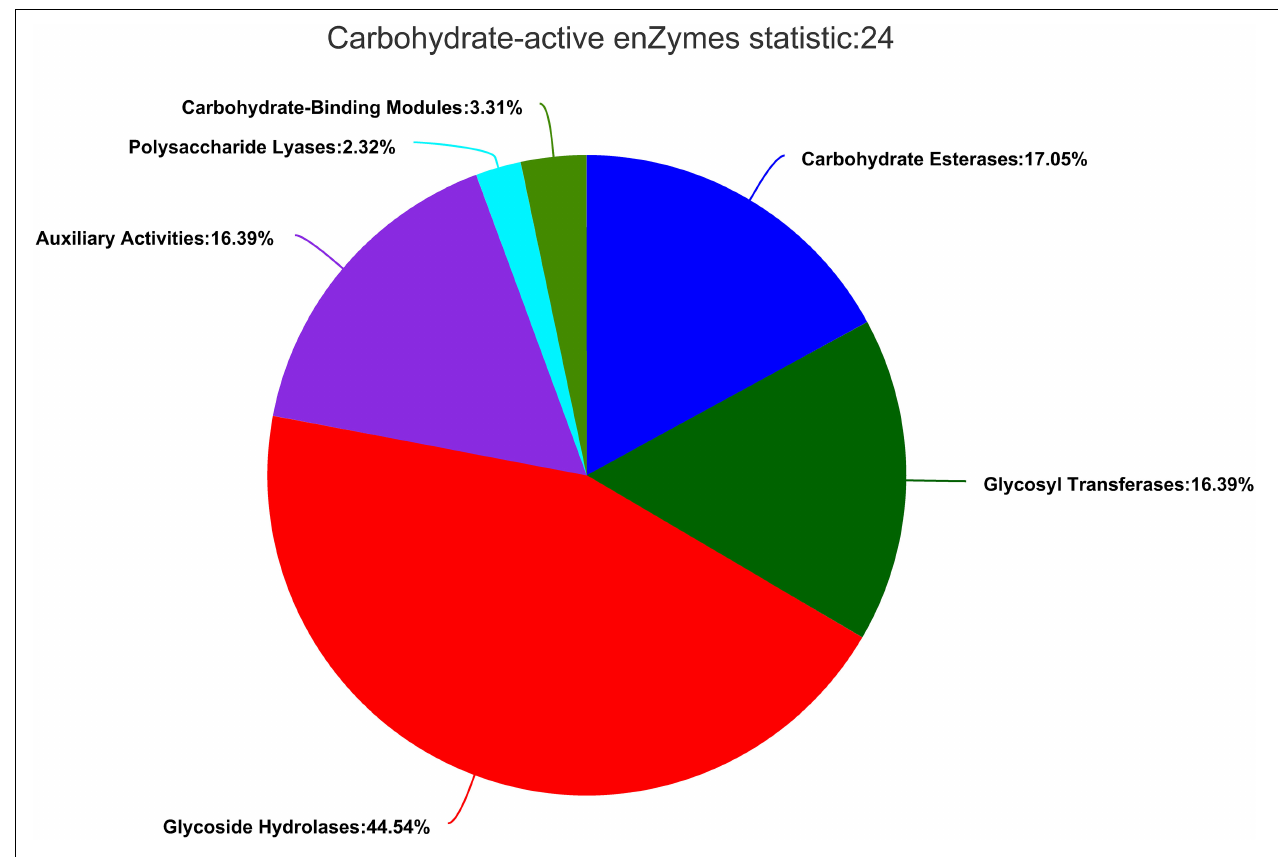
FIGURE 6 | Gene count distributions of carbohydrate-active enzyme (CAZy)